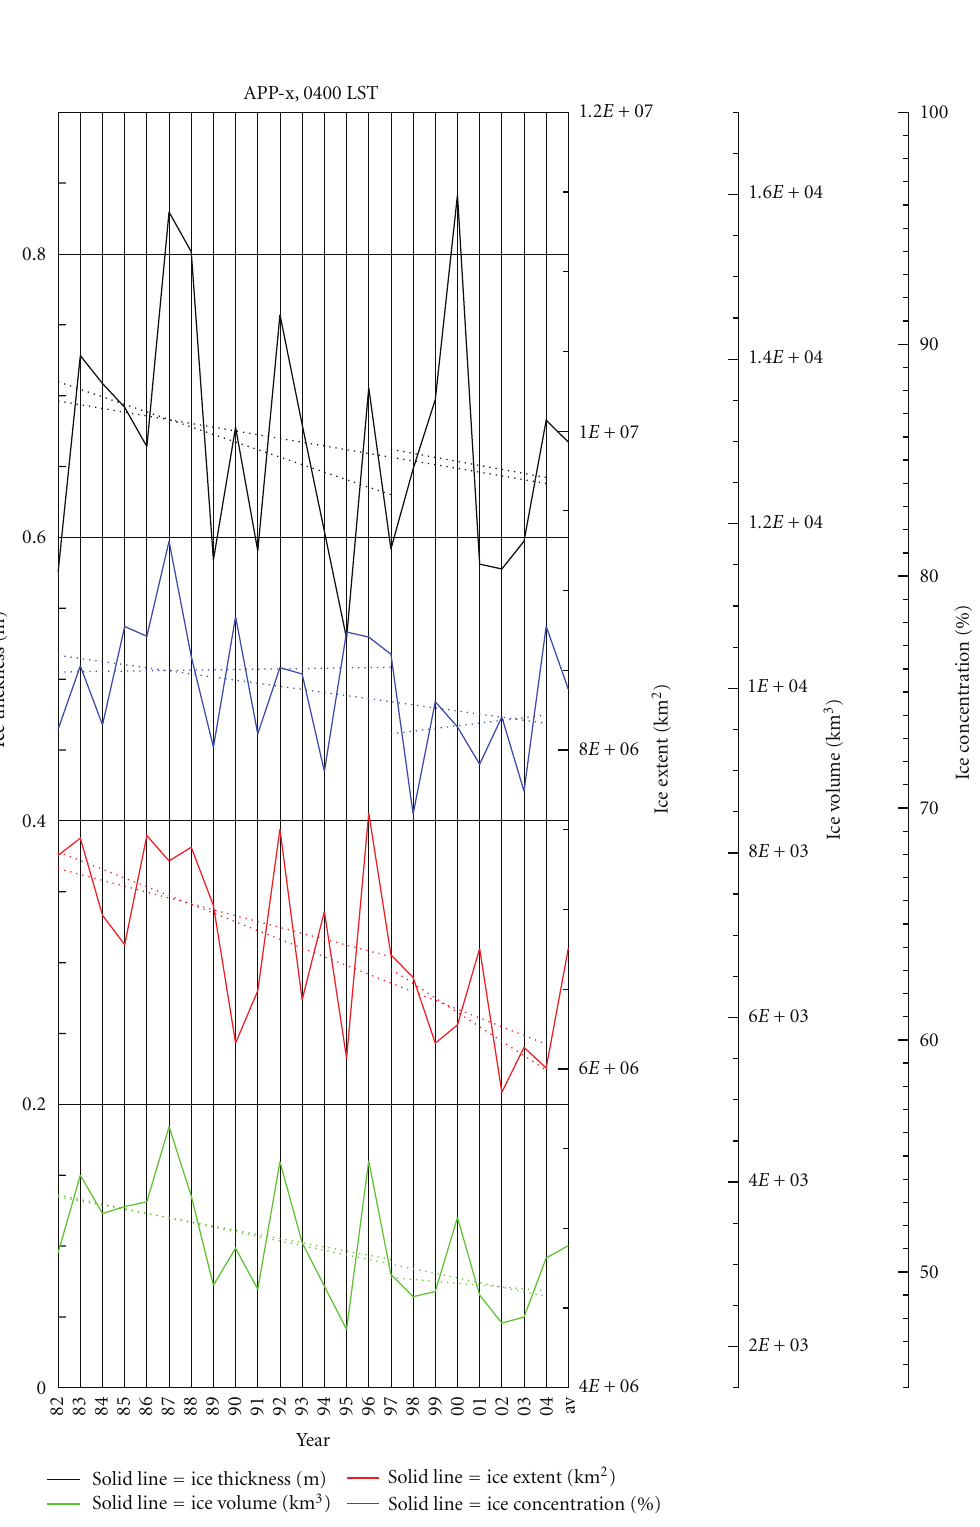
Figure 13: Time series of monthly mean sea ice extent, concentration, thickness, and volume for September over the period 1982–2004 for the Arctic Ocean north of 60 ◦